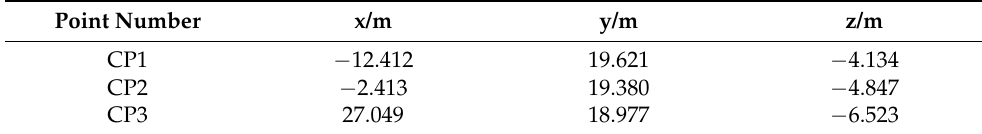
Table 8. Coordinates of three triangular pyramid vertices in phase 2.